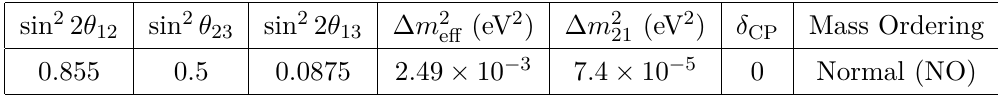
Table 2 . The benchmark values of oscillation parameters considered in this analysis. These values are in good agreement with the present neutrino global fits